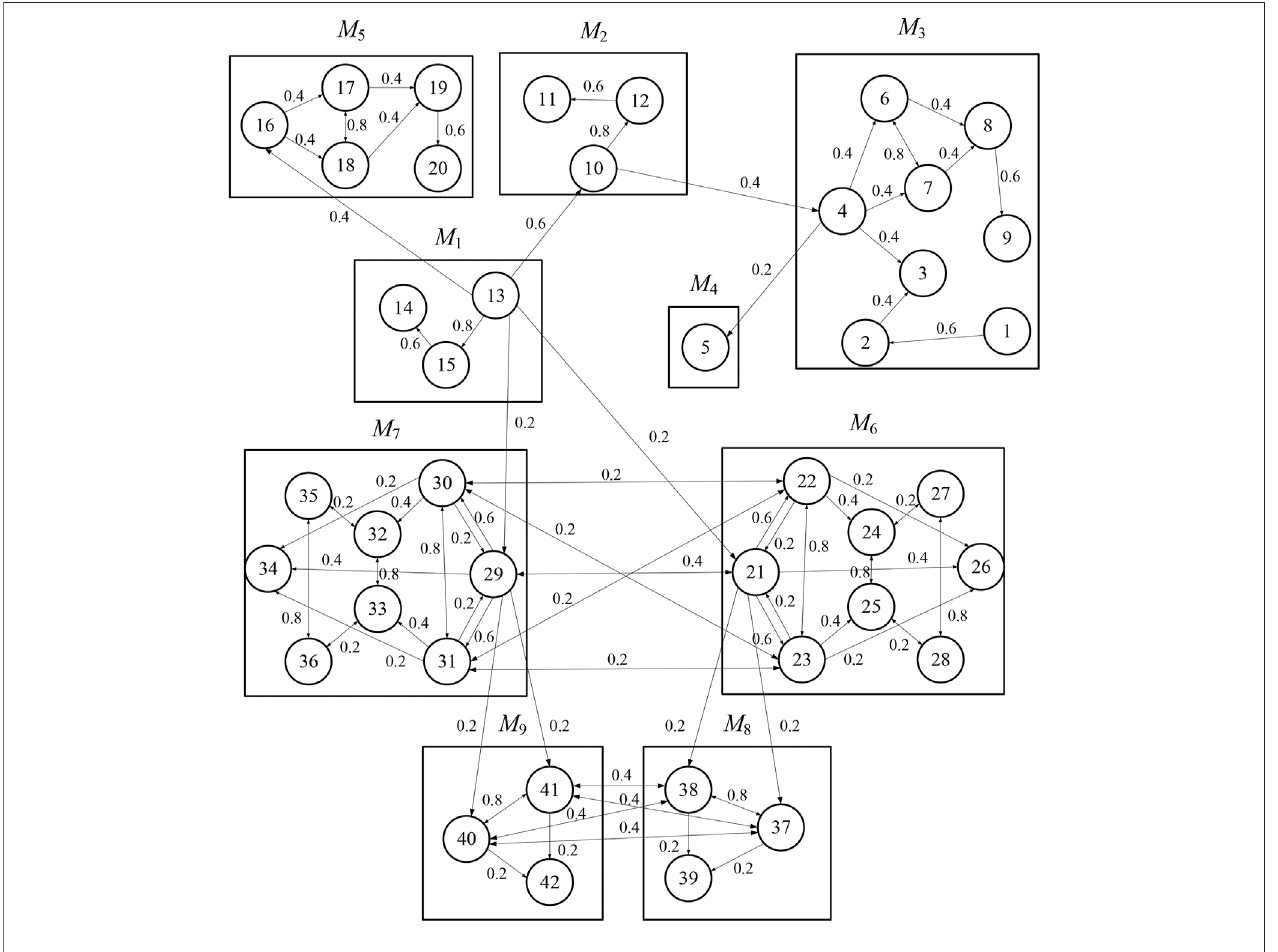
FIGURE 9 | Change propagation network for the